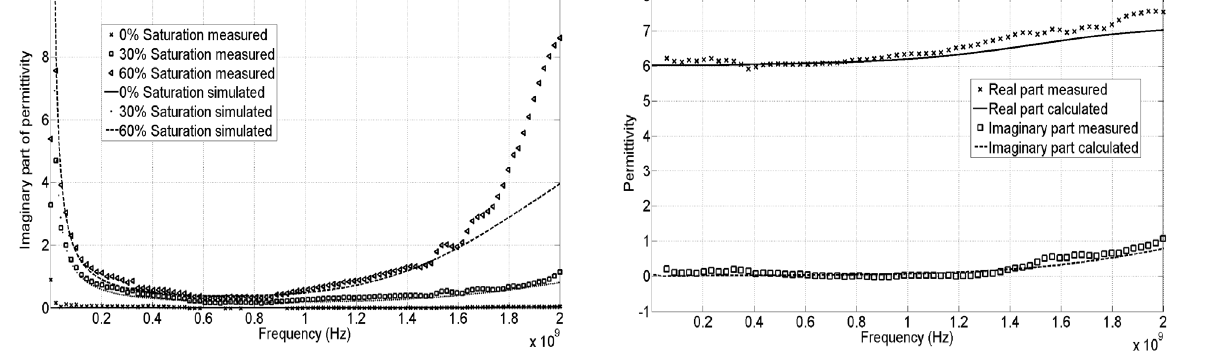
Figure 16. Measurement of the real and imaginary parts of the permittivity of a concrete sample compared to a simulated material (permittivity set at 6).